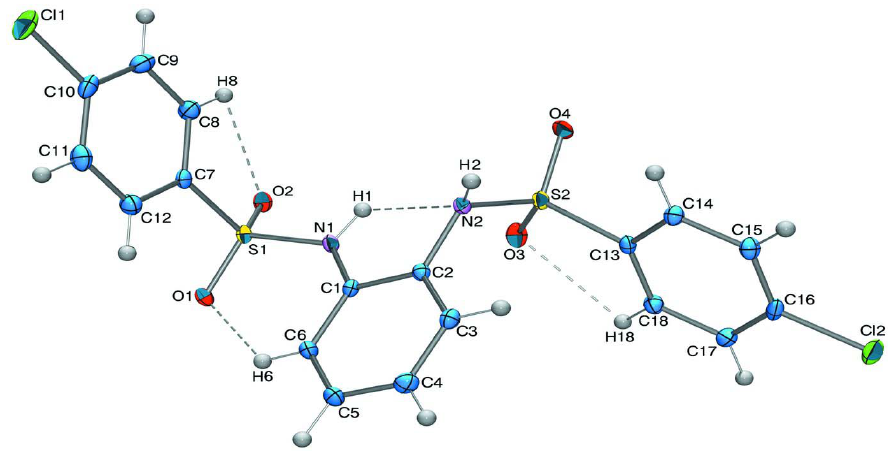
Figure 1 A view of (I) showing the molecular structure and intramolecular H bonding present. Displacement ellipsoids are drawn at the 30% probability level.